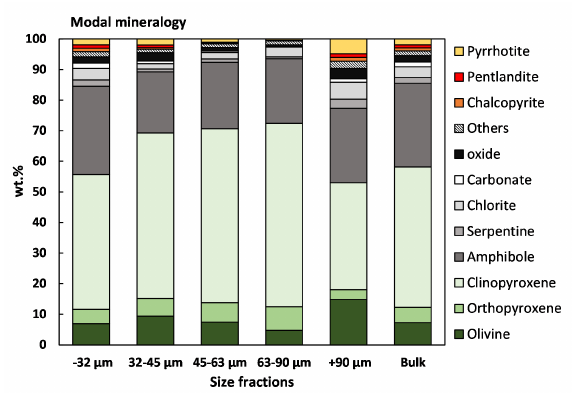
Figure 3. Modal mineralogy of the feed.